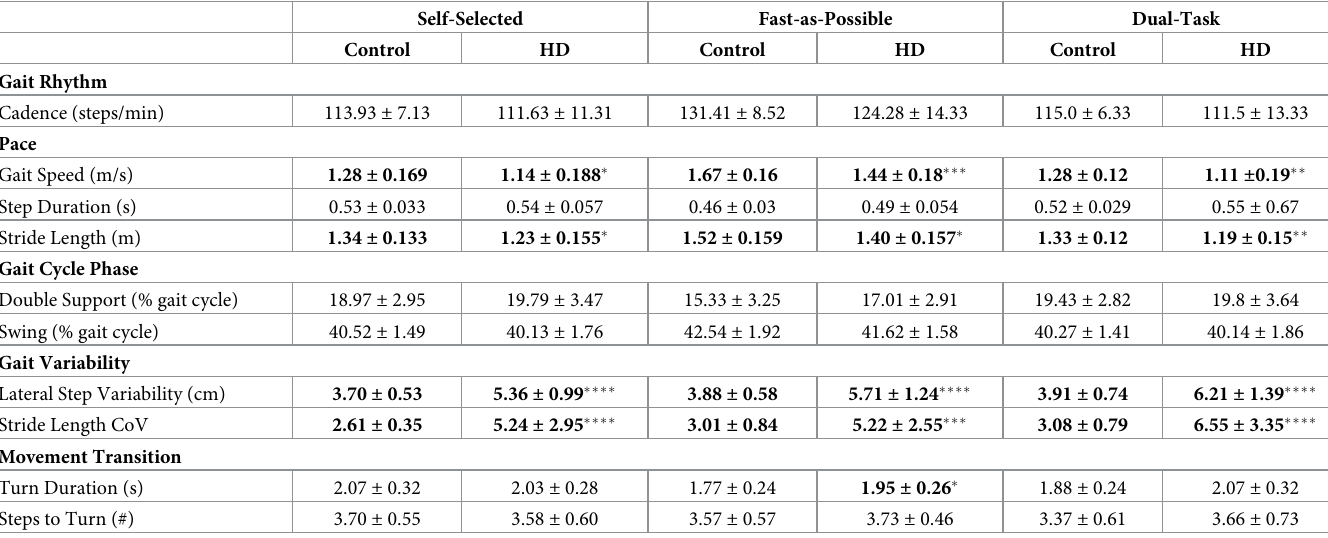
Table 2. Gait and turning during SS, FAP, and DT